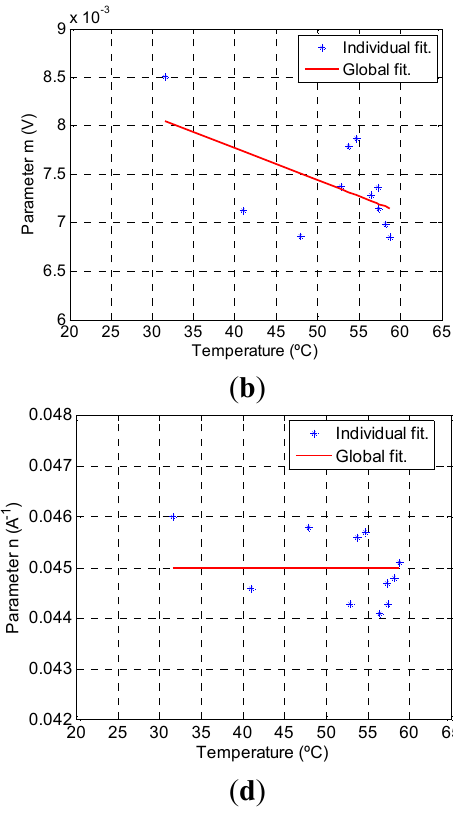
Individual fit. Global